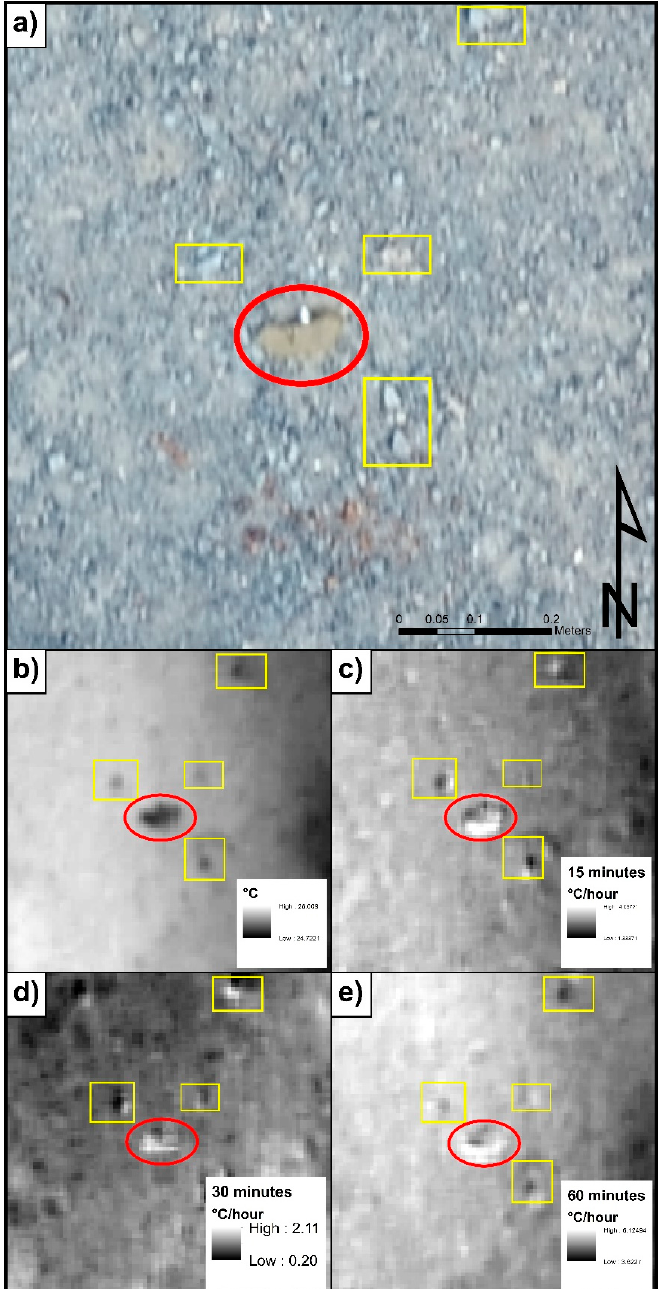
Figure 7. UAV image at 10 m above ground level of PFM-1 (shown in red oval) captured by ( a ) Visible light and ( b ) apparent temperature at 09:15, and differential apparent thermal inertia for short-term time-series at: ( c ) 15 min, ( d ) 30 min, and ( e ) 60 min. Yellow rectangles indicate larger rocks as potential sources of thermal clutter, which can be discriminated in differential apparent thermal inertia (DATI) images.